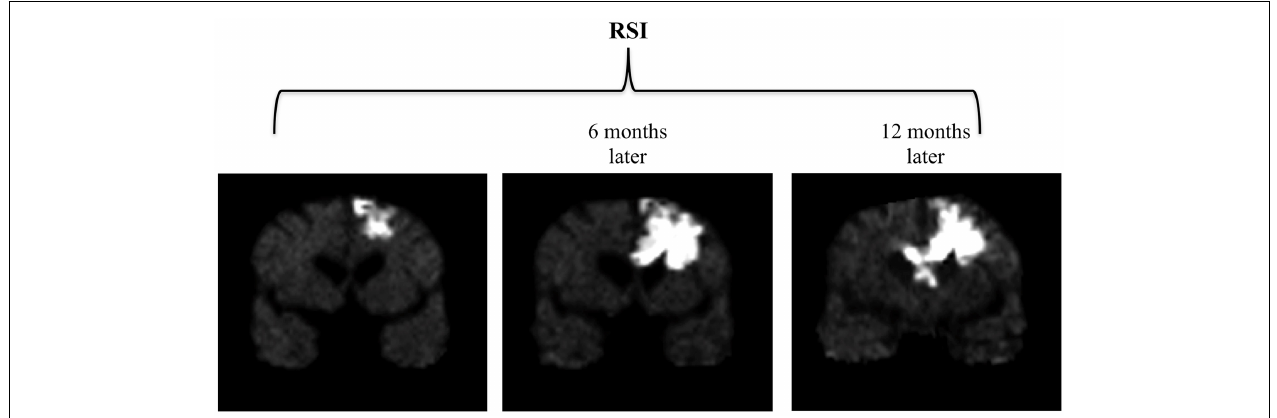
FIGURE 1 | Progression of findings on RSI over a 12-month period .Three coronal RSI images spanning a 12-month period following surgery and chemoradiation depict an enlarging area of restricted diffusion which eventually crosses the corpus callosum and extends into the contralateral frontal lobe.